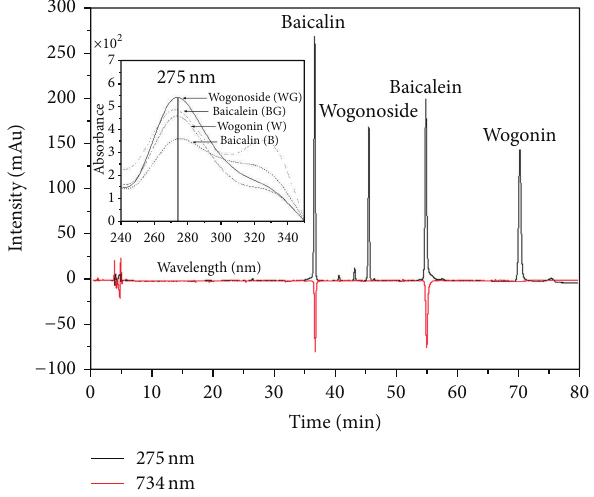
Figure 4: Chromatogram of online screening HPLC-ABTS radical scavenging of standard chemical